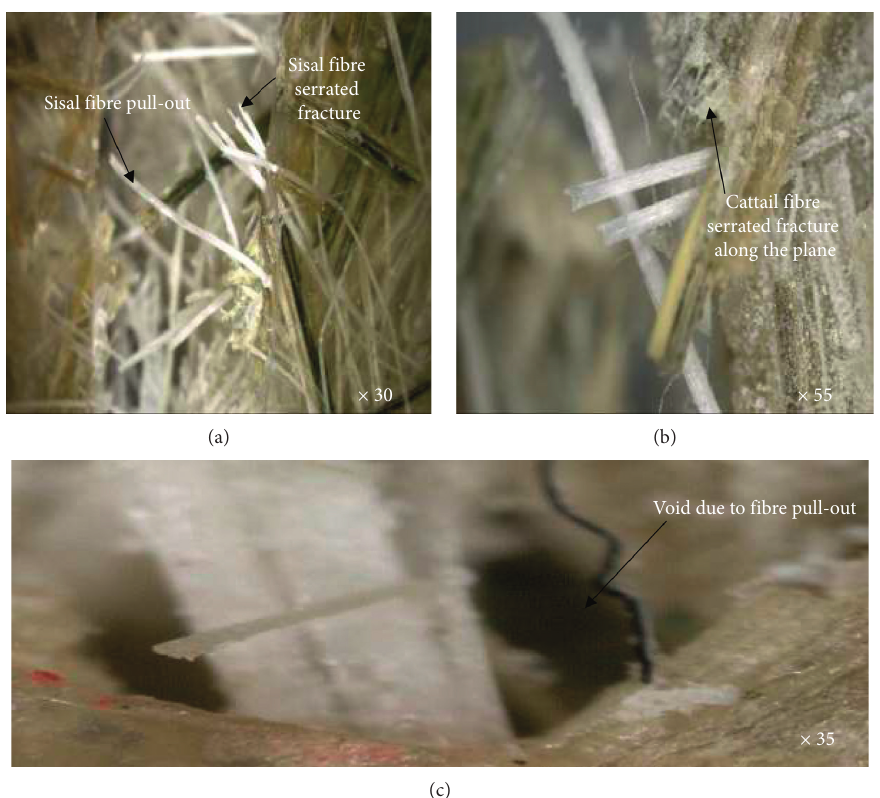
Figure 11: Hybrid composites with 20 wt% hybrid fibre weight fraction and 50/50 sisal/cattail fibre content in the hybrid after tensile test.